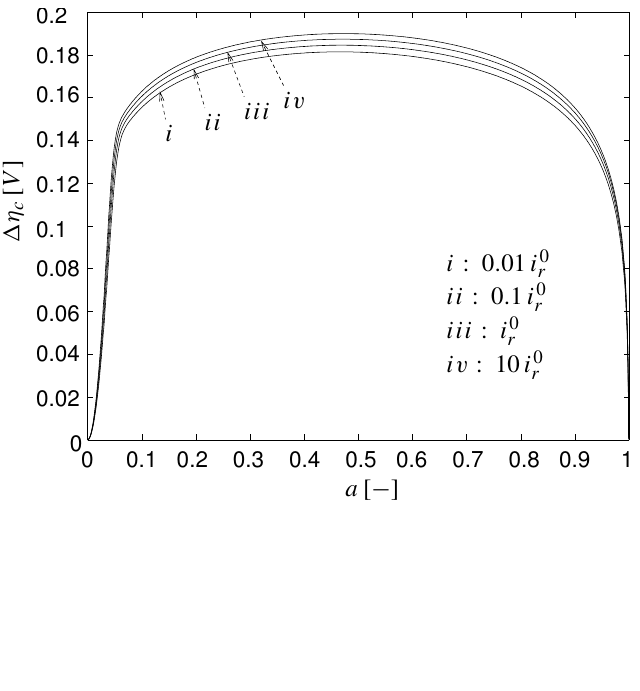
of the overpotential with respect to the c . r